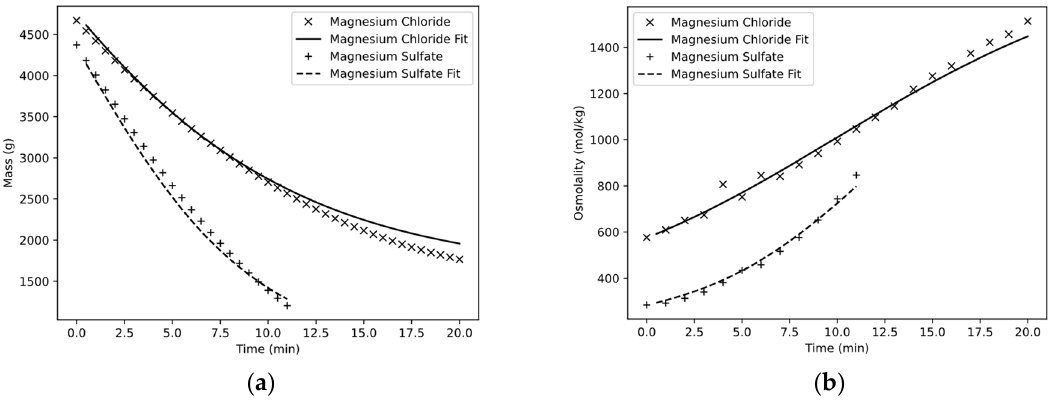
Figure 6. Mass ( a ) and osmolality ( b ) of the storage tank as a function of